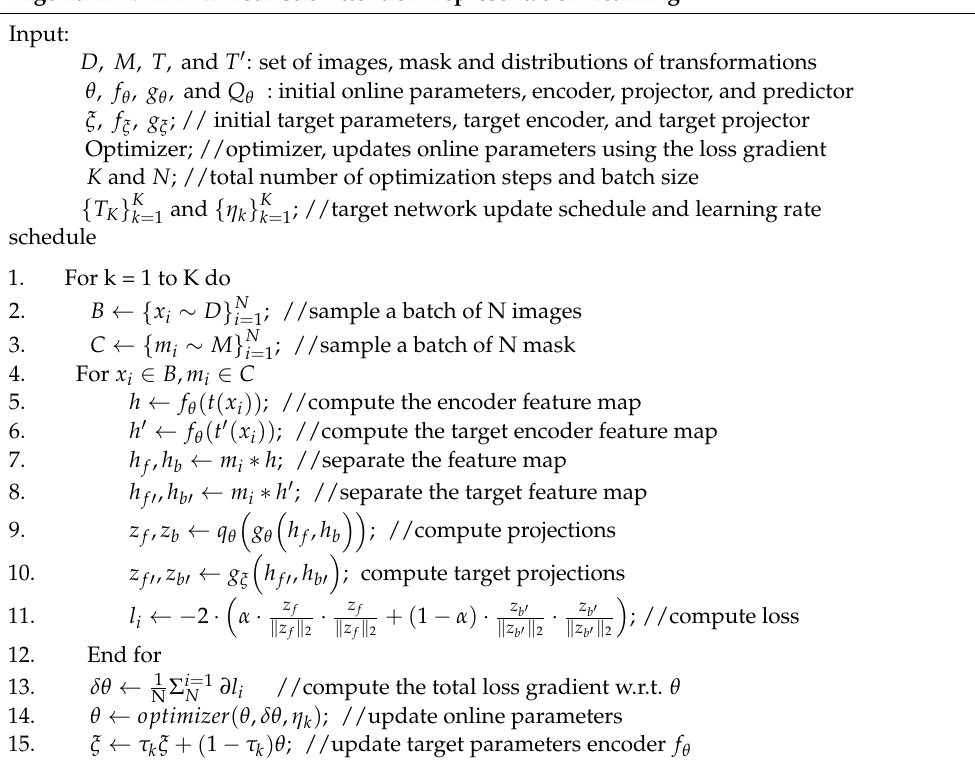
Algorithm 1: HARL: Heuristic Attention Representation